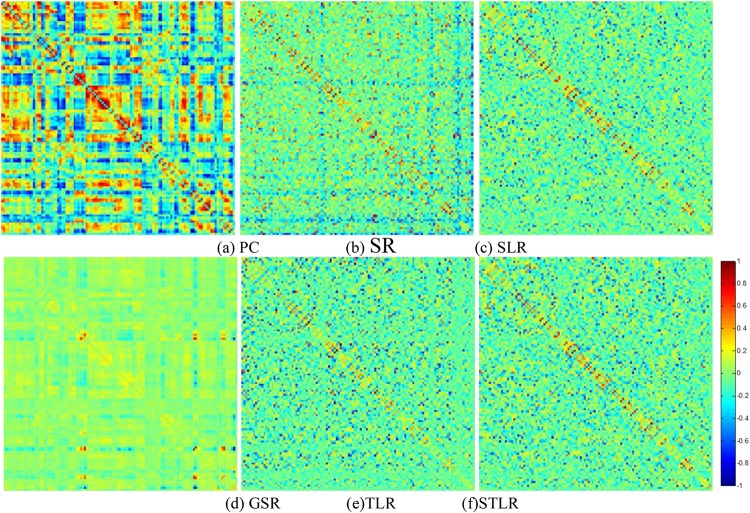
The FBN adjacency matrices of a certain subject, constructed by (a) PC, (b) SR, (c) SLR, (d) GSR, (e) TLR and (STLR).